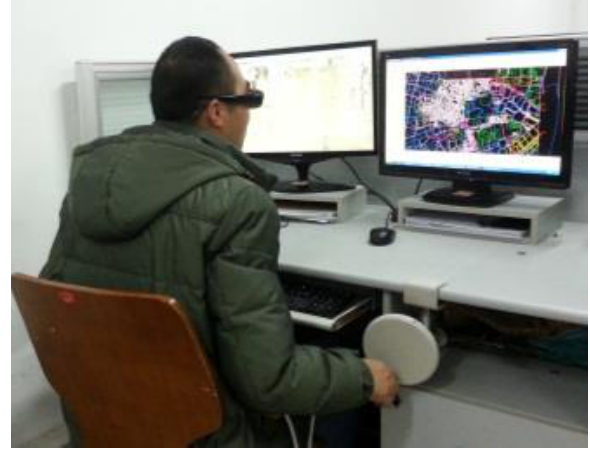
Figure 2. Photogrammetry-based